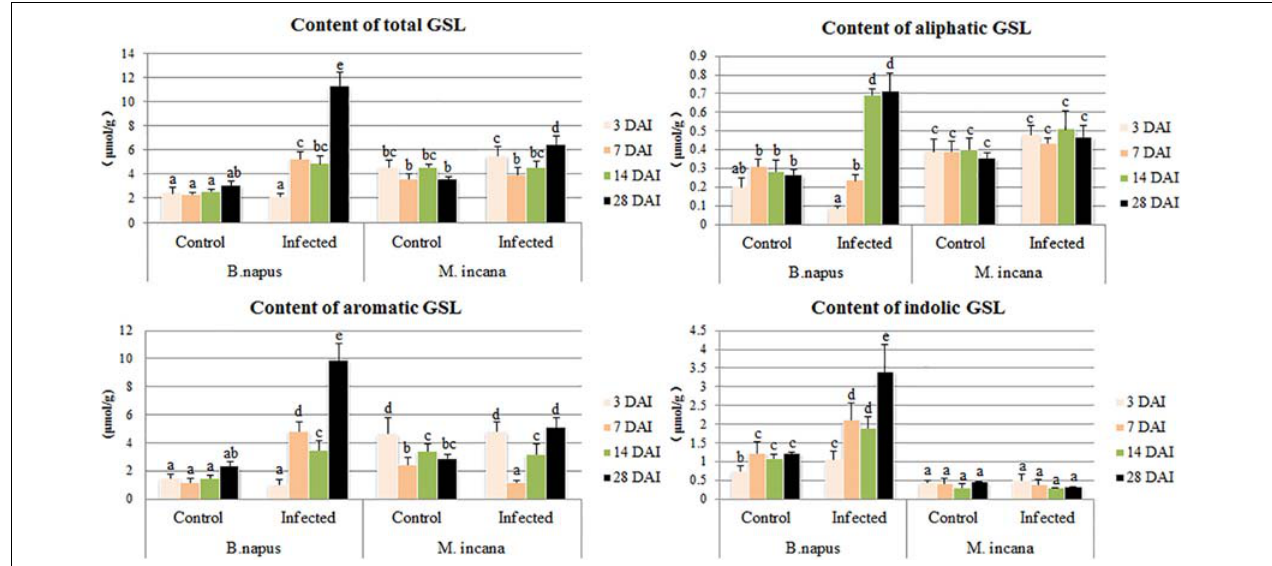
FIGURE 5 | Content of glucosinolates (GSLs) in the roots of B. napus and M. incana at 3, 7, 14, and 28 days after inoculation (DAI). Error bars represent the standard errors of three independent experiments. Different letters above the bars indicate that the differences are significant ( P < 0.05).